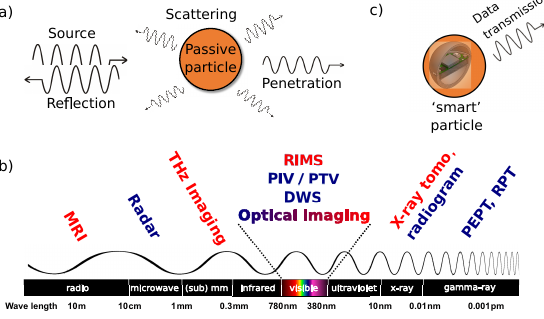
Figure 2: (a) A sketch illustrating physical mechanisms associated with ‘imaging’ particles. (b) Experimental methods to probe static (blue text) or dynamic (red text) or both types of properties (blue transitioning to red) of particulate materials in the bulk, by the wave- length of the electromagnetic radiation being used. (c) A ‘smart’ tracer capable of monitoring local properties and transmitting digital data via wireless communica-